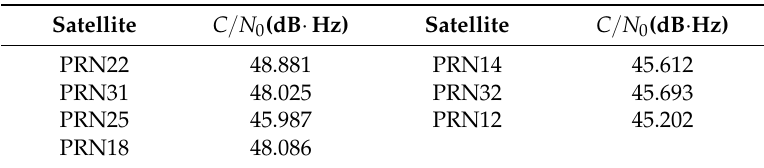
Table 1. C { N 0 of selected